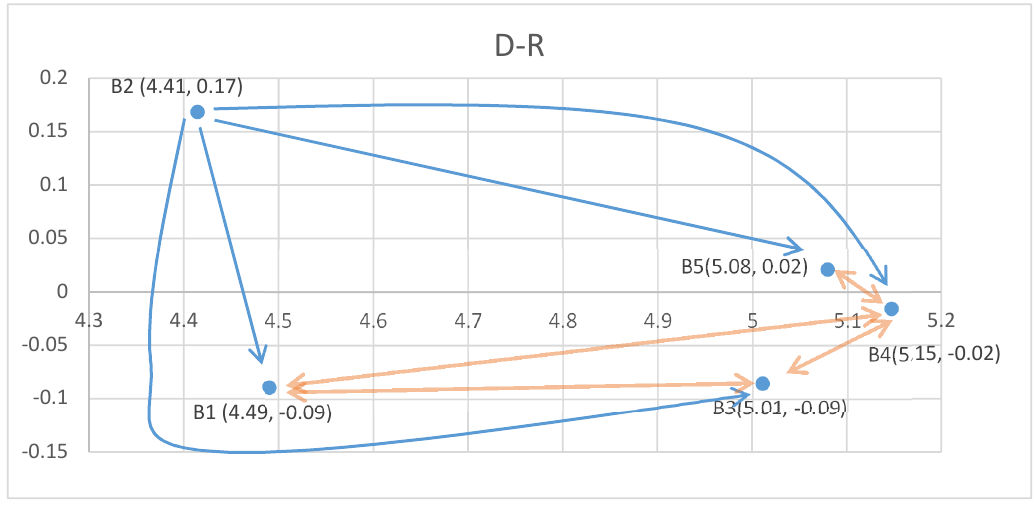
Figure 4. Scatter plot of the correlation (D + R) and causality (D − R) results for the ecological aspect.